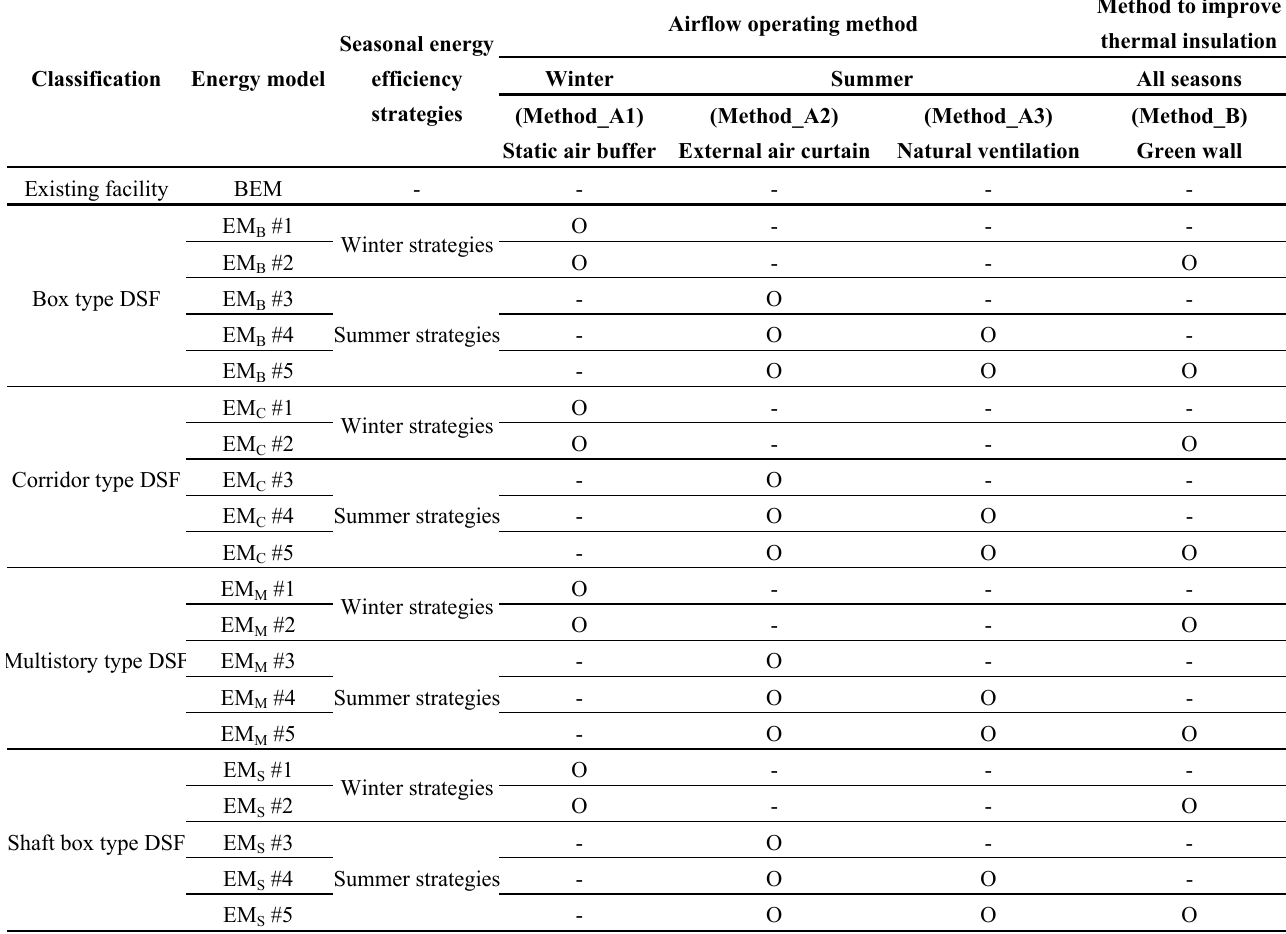
Table 5. Establishment of energy models with seasonal energy efficiency